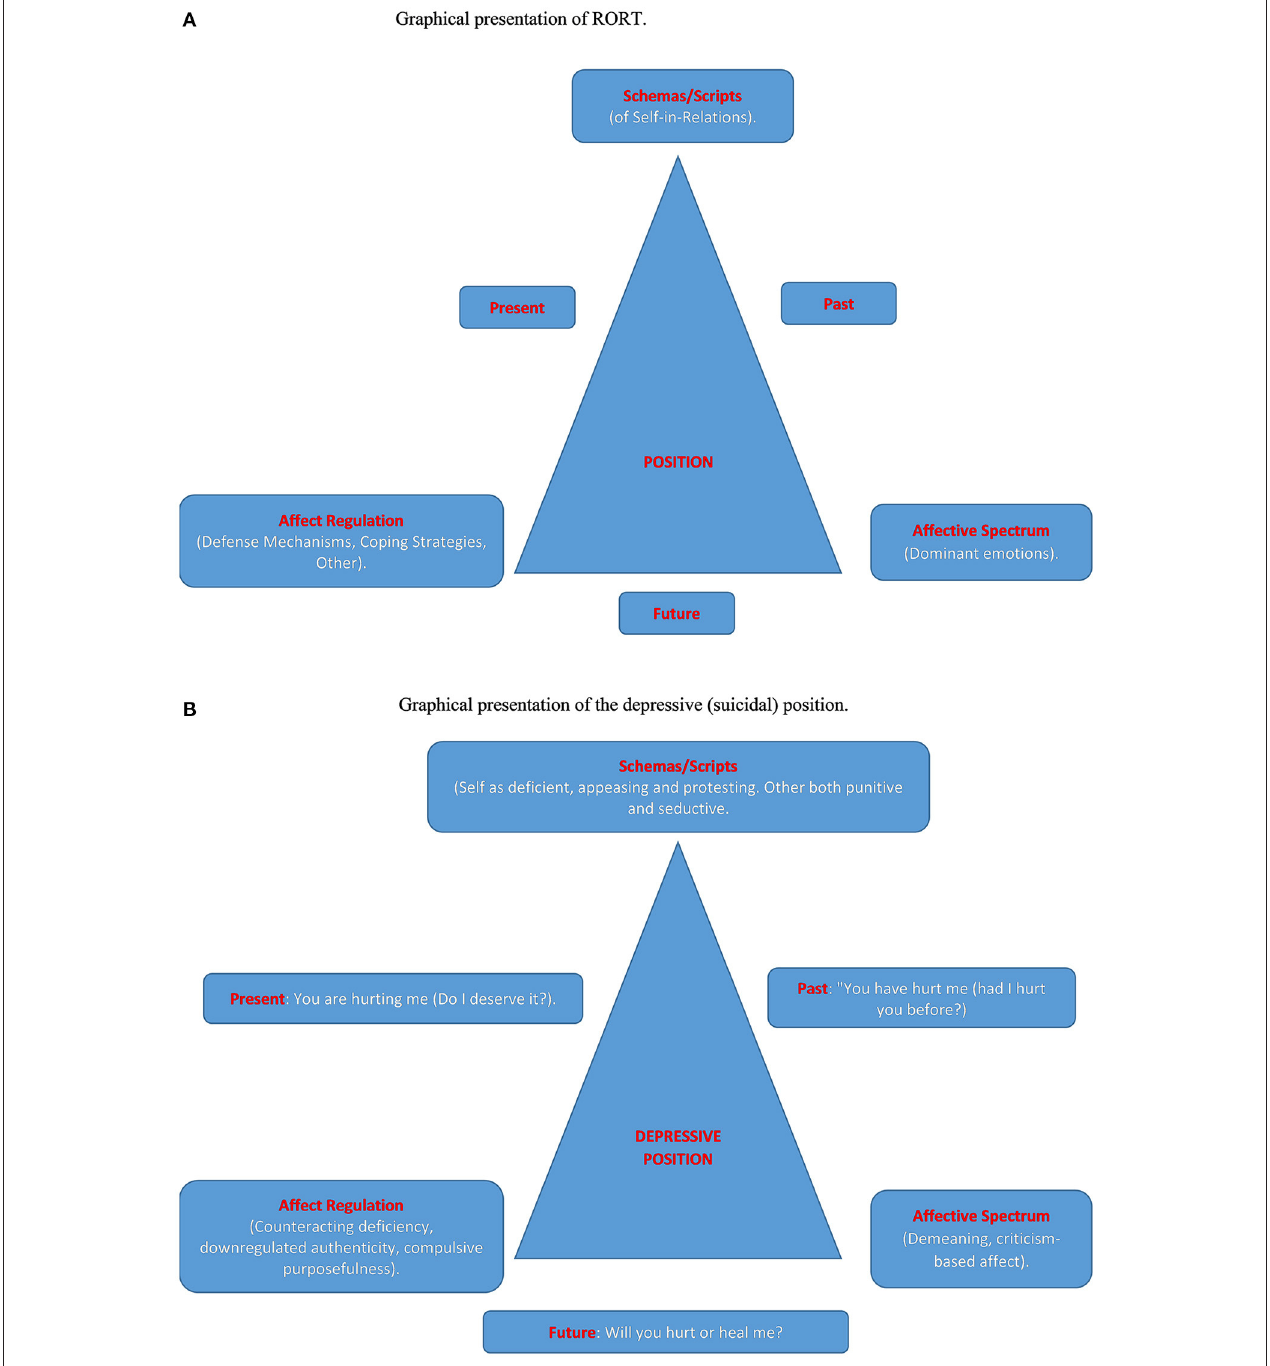
FIGURE 1 | (A) Graphical presentation of RORT. (B) Graphical presentation of the depressive (suicidal) position.